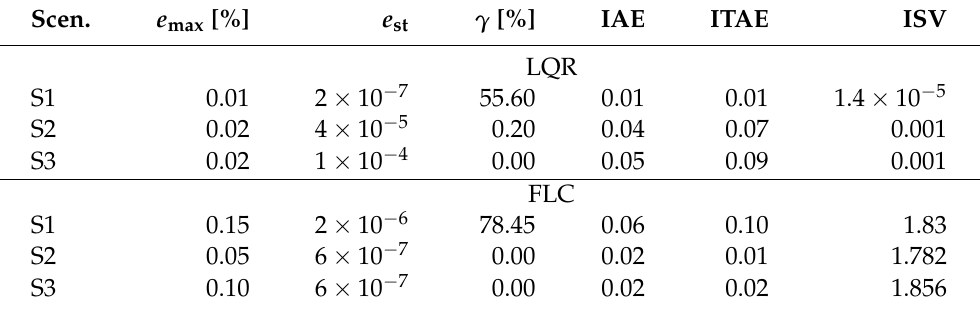
Table 7. Quality indexes of the LQR and FLC—Area 2.